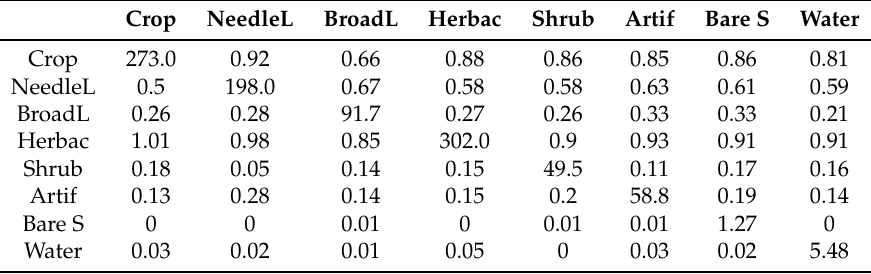
Table A10. Confusion matrix for the reference with uniform error values for each class and overall accuracy of